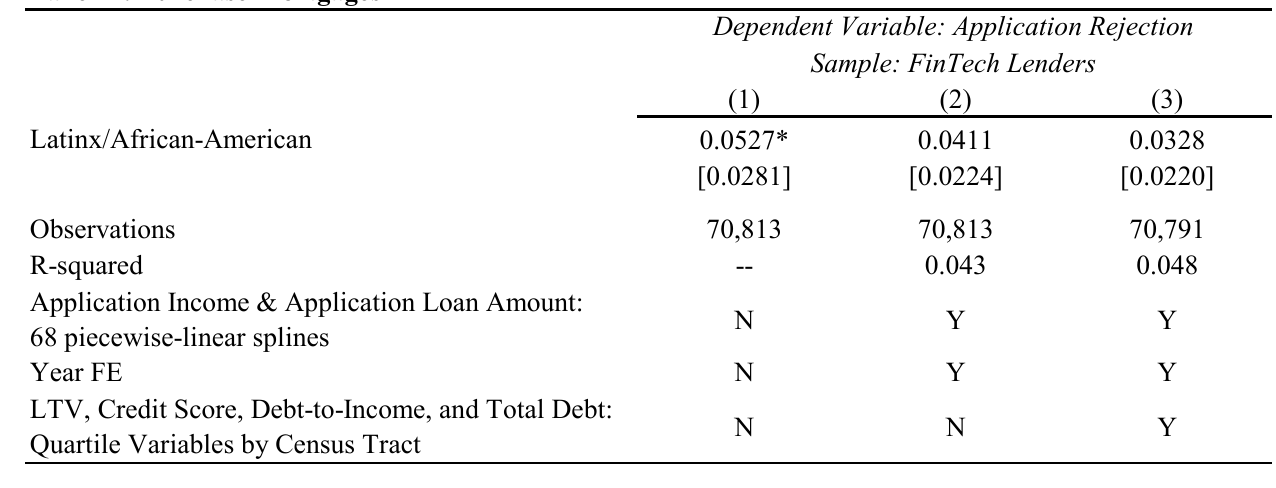
Table 8: Application Rejection Discrimination - FinTech